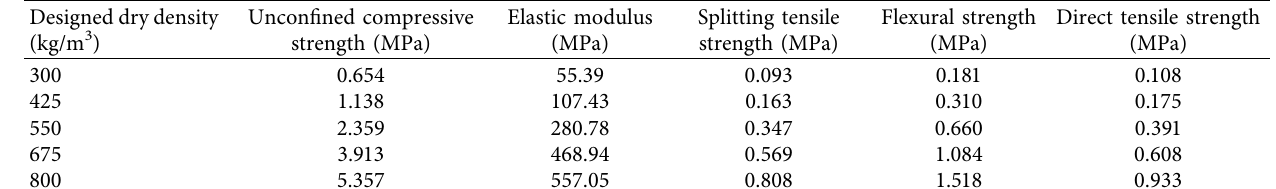
Table 3: The results of mechanical tests.